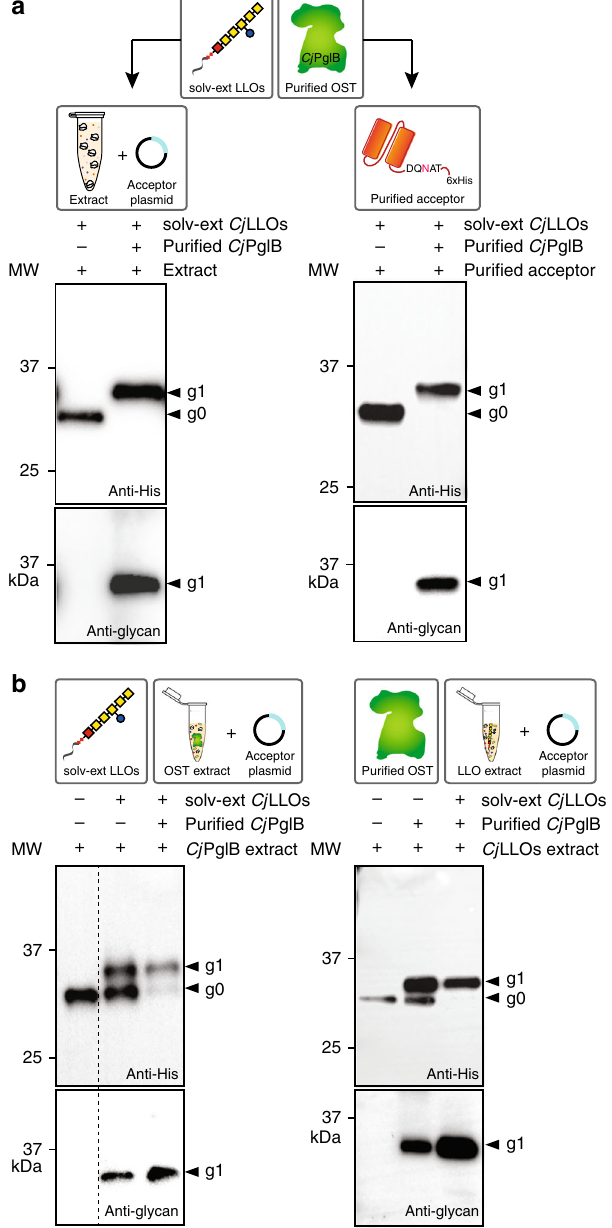
Fig. 2 Extract from glyco-optimized chassis strain supports CFGpS. a (left) Western blot analysis of scFv13-R4 DQNAT produced by crude CLM24 extract supplemented with puri fi ed Cj PglB and organic solvent-extracted (solv-ext) Cj LLOs, and primed with plasmid pJL1-scFv13-R4 DQNAT . (right) Western blot analysis of in vitro glycosylation reaction using puri fi ed scFv13-R4 DQNAT acceptor protein that was incubated with puri fi ed Cj PglB and organic solvent-extracted (solv-ext) Cj LLOs. Control reactions (lane 1 in